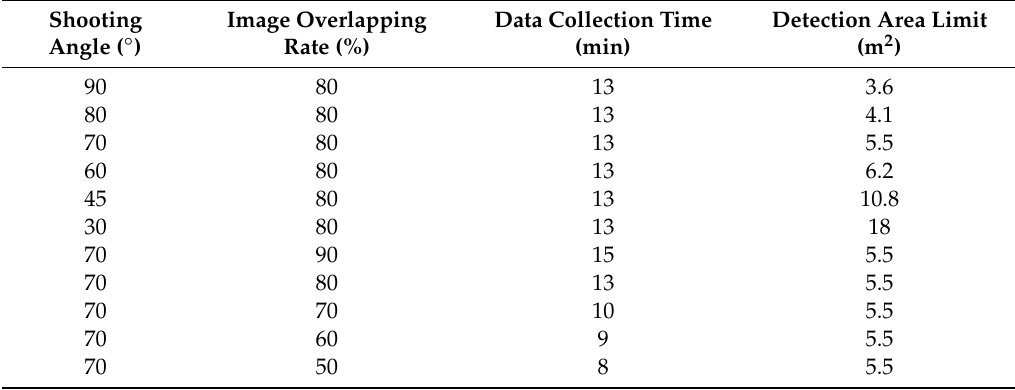
Table 6. Di ff erent settings and application information of the CGC-CRP